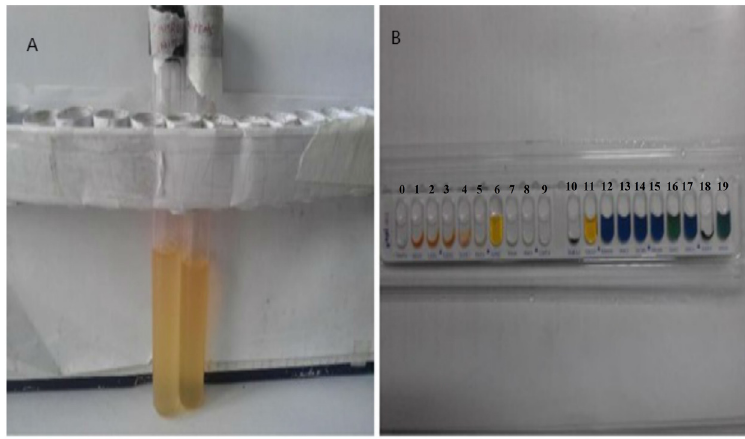
Figure 2. Biochemical tests to identify yeast species. ( A ) Negative nitrate reduction test indicated by the yellow color (positive test would result in red color change) ( B ) API 20 C X kit results for different carbohydrates fermentation using API kit after 48 hours. Color in the chamber indicates a positive result, negative results retain the yellow color of the broth. Active ingredients contained in each chamber from left to right: 0 – none, 1 – D-glucose, 2 – Glycerol, 3 – Calcium 2-keto-D-gluconate, 4 – L-arabinose, 5 – D-xylose, 6 – Adonitol, 7 – Xylitol, 8 – D-galactose, 9 – Inositol, 10 – D-sorbitol, 11 – Methyl α -D-glucopyranoside, 12 – N-acetylglucosamine, 13 – D-cellobiose, 14 – D-lactose, 15 – D-maltose, 16 – D-saccharose/Sucrose, 17 – D-trehalose, 18 – D-melezitose, 19 – D-raffinose.